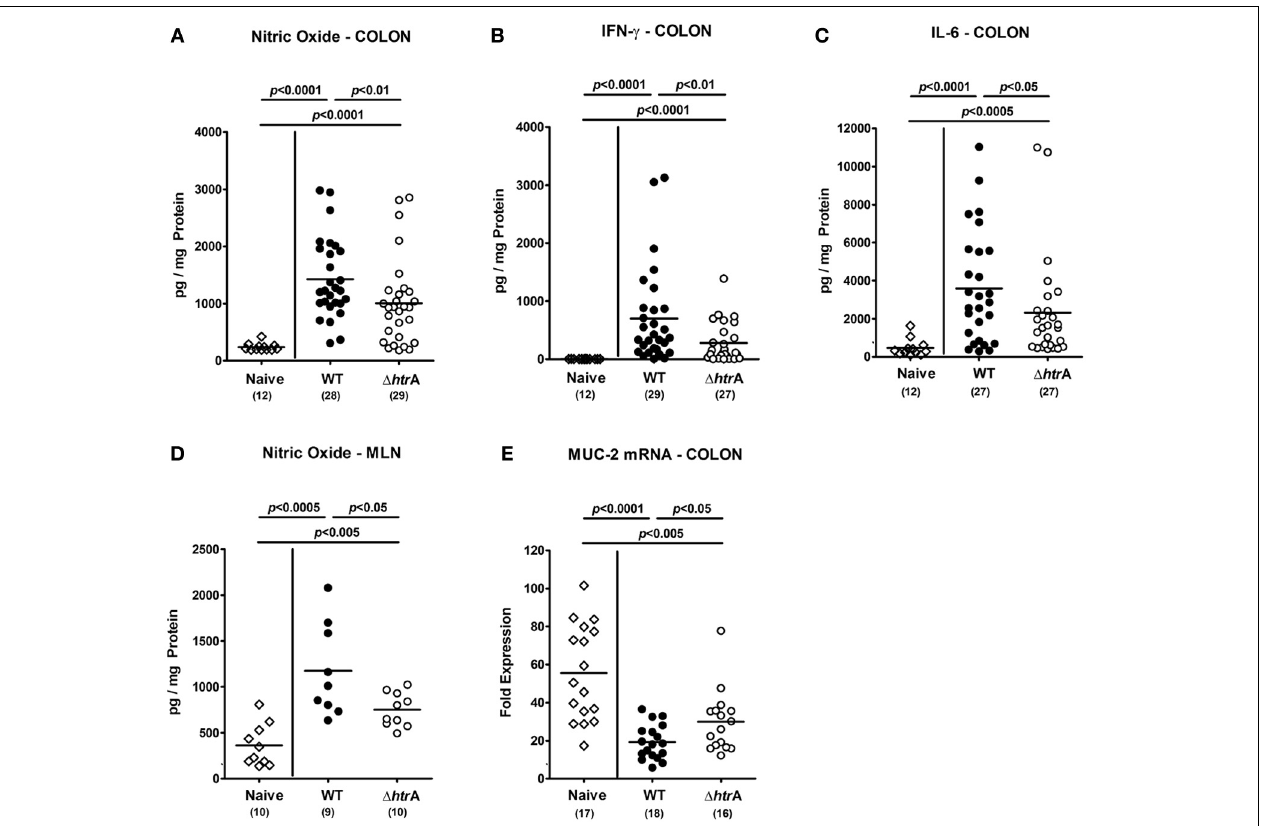
FIGURE 4 | Importance of C. jejuni htrA gene expression in intestinal pro-inflammatory cytokine responses and mucin-2 expression induced during infection of gnotobiotic IL-10 − / − mice. Colonic (A) nitric oxide, (B) IFN- γ , and (C) IL-6 levels, (D) nitric oxide concentrations